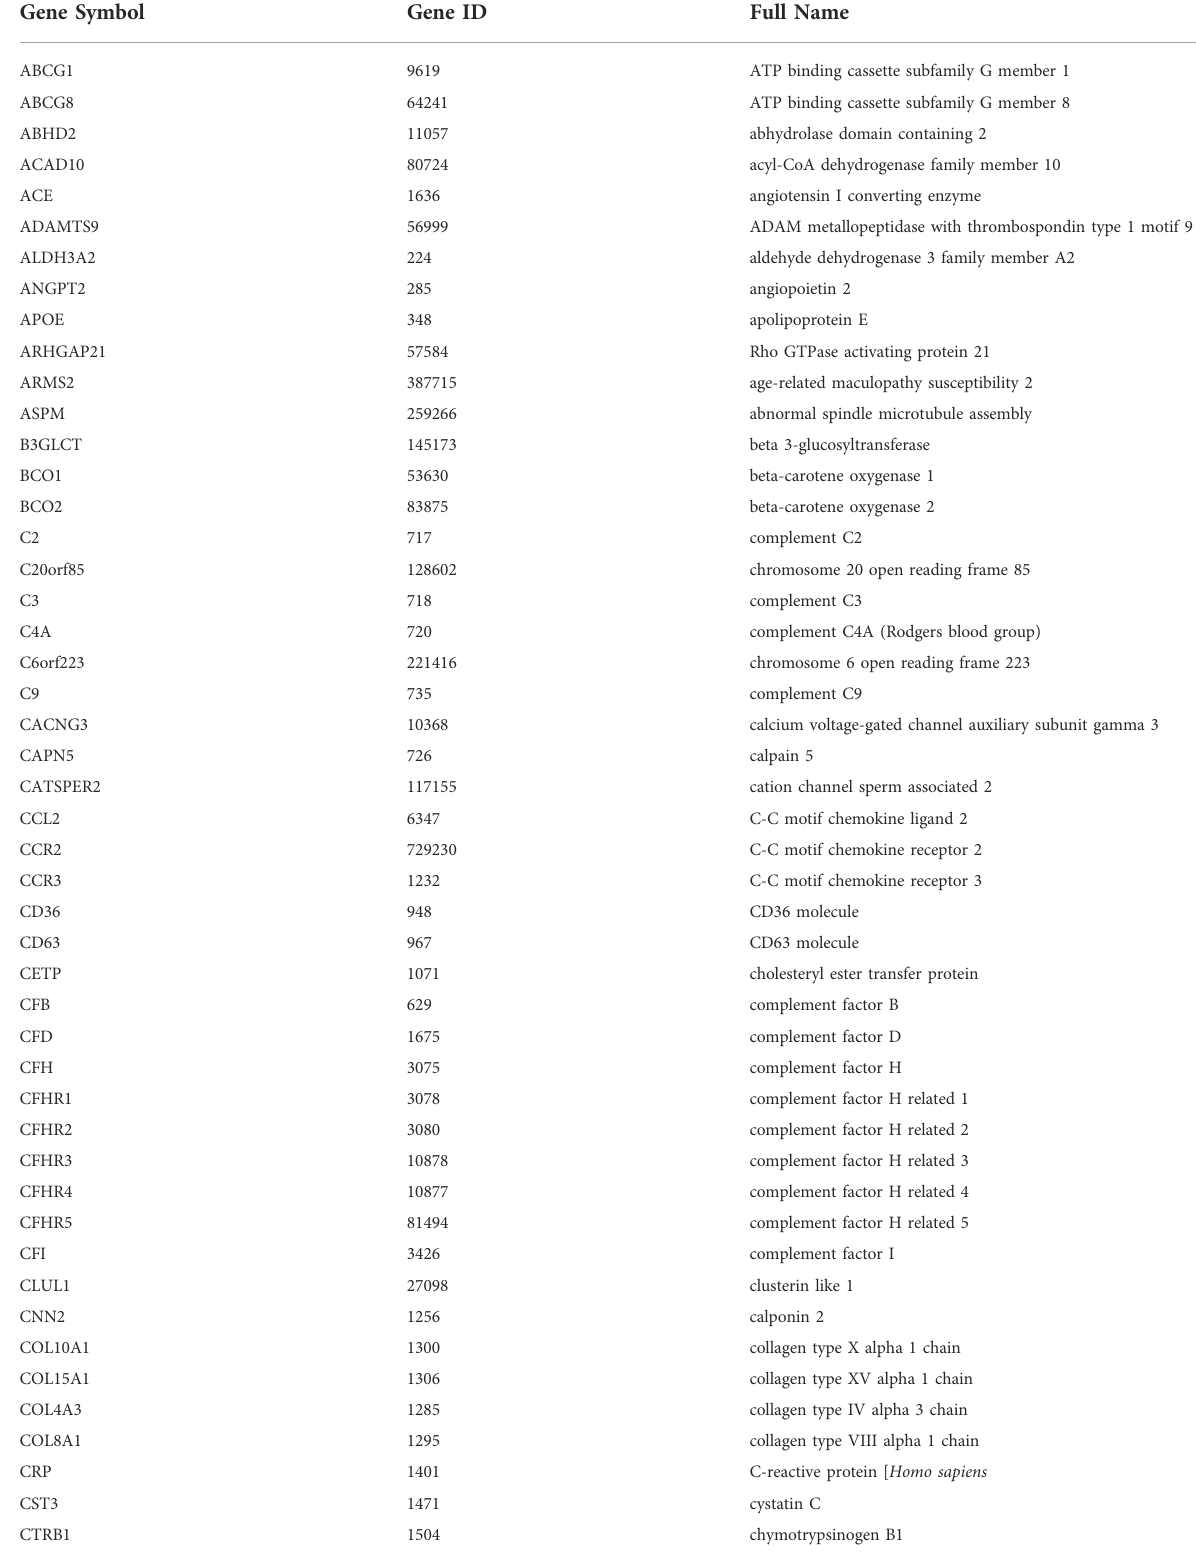
TABLE 1 Genes retrieved from human genetic association